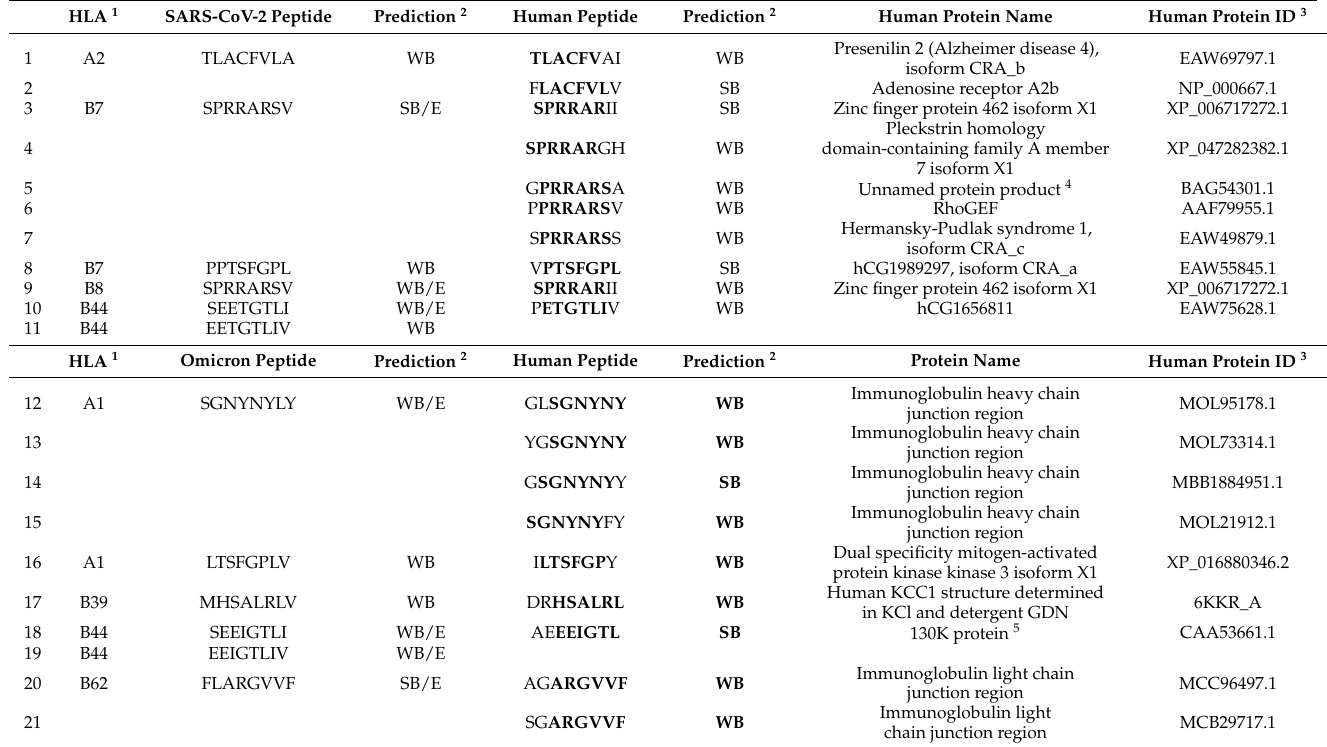
Table 2. Virus and human peptides sharing 6mers at the mutation sites of interest and having affinity to the same HLA. The first 11 data rows are the respective SARS-CoV-2 and human peptides. The corresponding SARS-CoV-2 peptides are those at the Omicron 21K-specific mutation sites, and at the mutation sites common to Omicron 21K and Omicron 21L (i.e., 21K + 21K/21L). The rows from 12 to the end display human peptides sharing 6mers with the respective Omicron (21K + 21K/21L) sequences. Empty cells indicate that the data is the same as the data in the last filled cell above that row. Shared residues in the human peptides are written in bold.